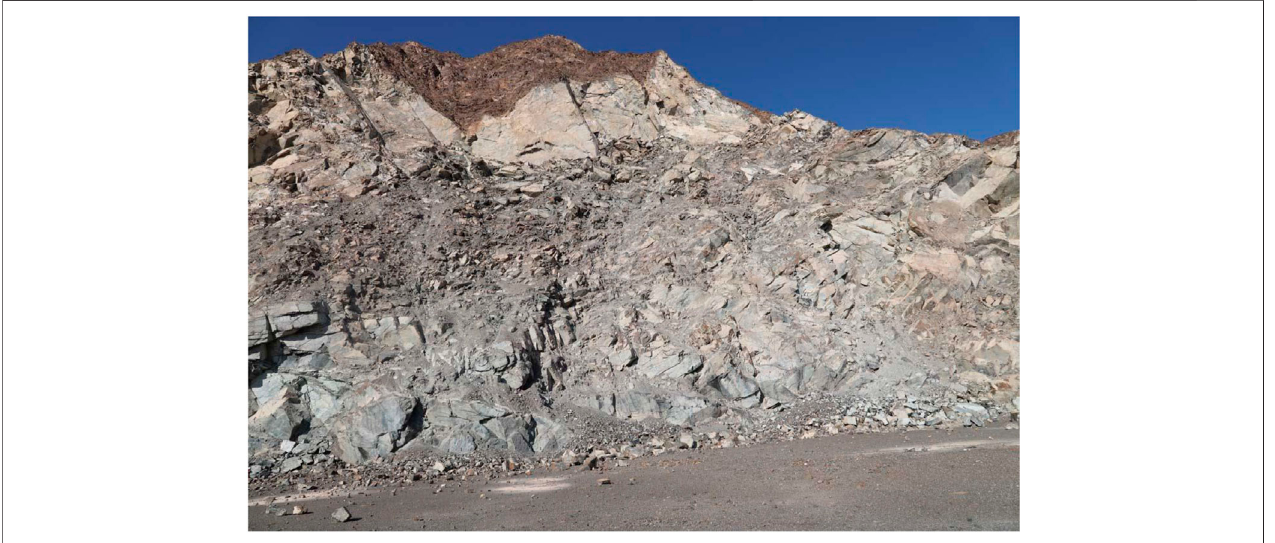
Frontiers in Earth Science |